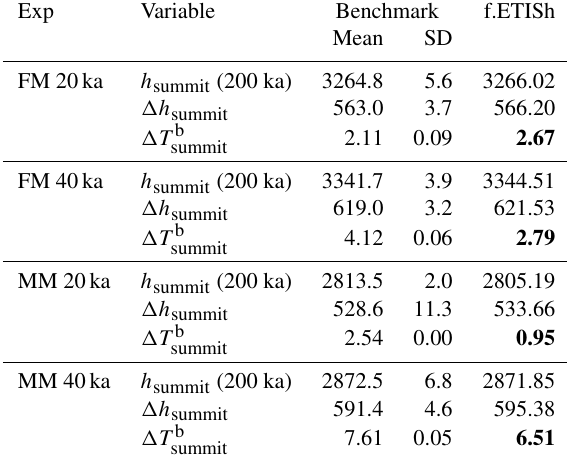
Table A2. Comparison of f.ETISh with the EISMINT-I fixed (FM) and moving margin (MM) experiment benchmark based on an en- semble of two to three models (Huybrechts et al., 1996) for the forc- ing experiments with a sinusoidal signal of 20 and 40 ka, respec- tively. Bold values are those outside the range given by the bench- mark results.